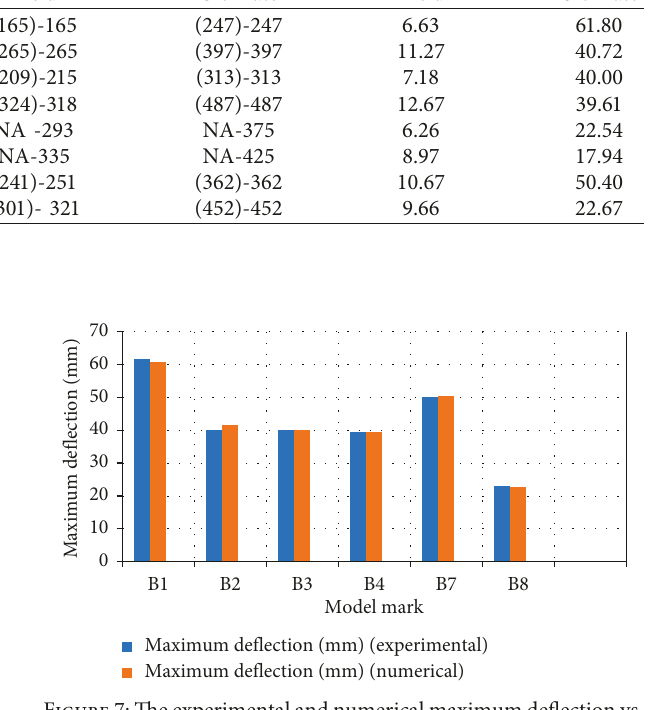
Figure 6: The experimental and numerical yield deflection vs. model.